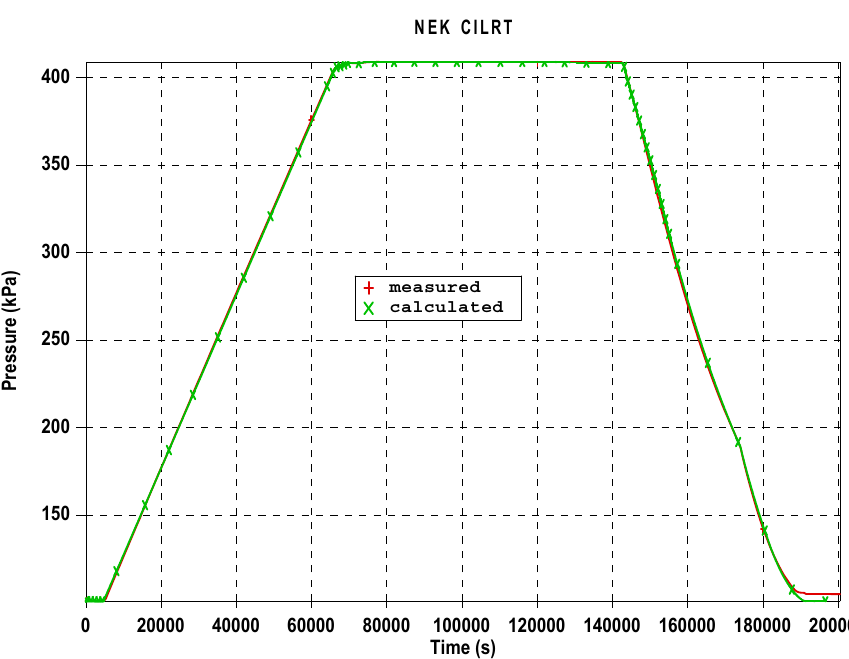
Figure 3. Measured and calculated containment pressures during the test.